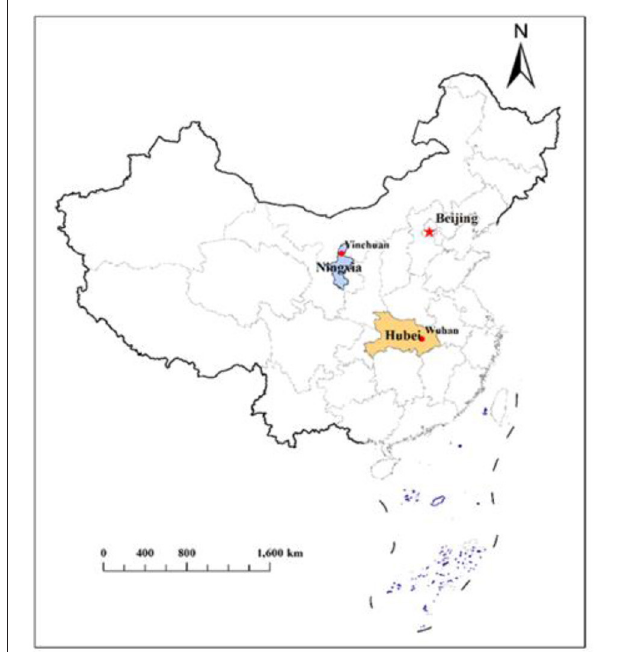
FIGURE 1 | The geographical location of Ningxia Hui Autonomous Region in